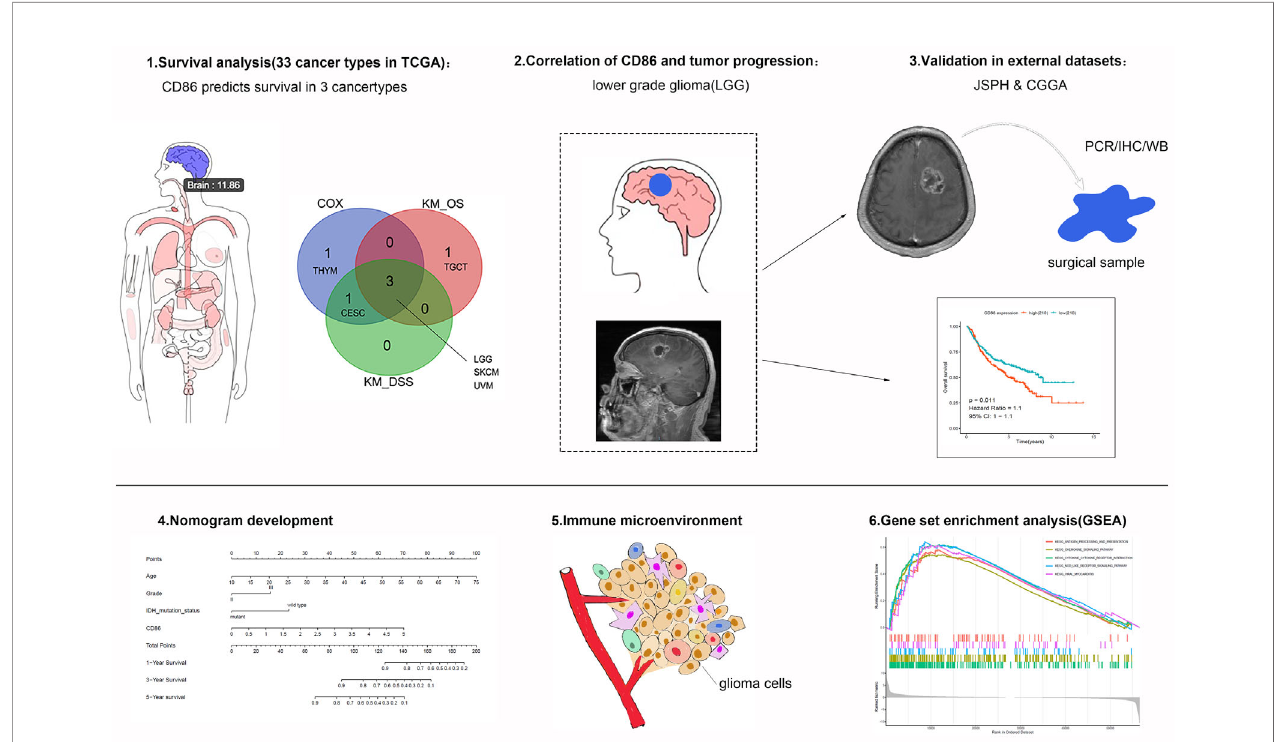
FIGURE 1 | Schematic fl owchart of the study process. The top left panel indicates that CD86 expression level of the brain is 11.86 [expression= Log 2 (TPM +